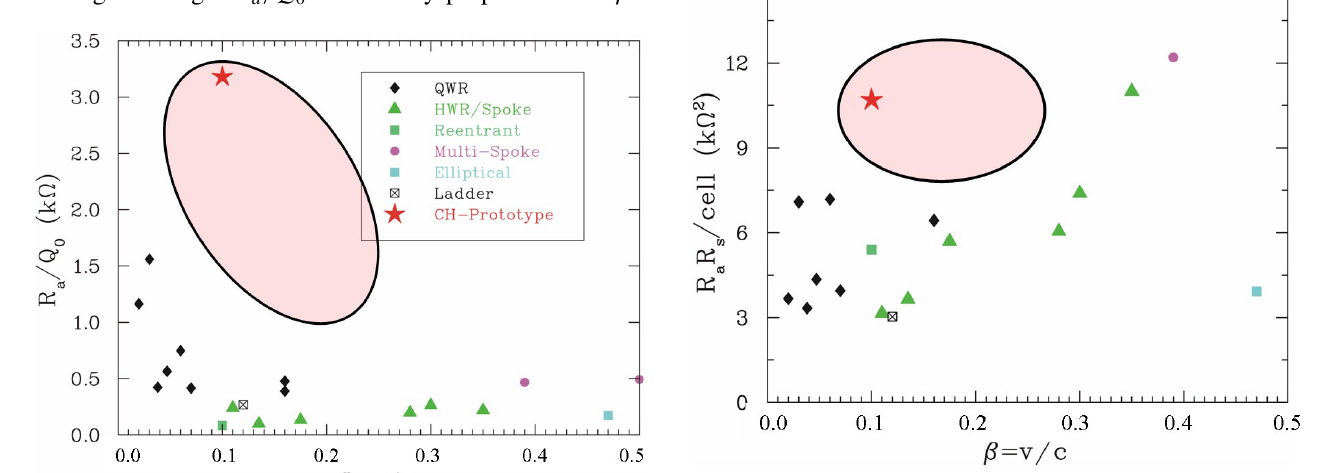
=Q value as a function of (cid:1) a 0